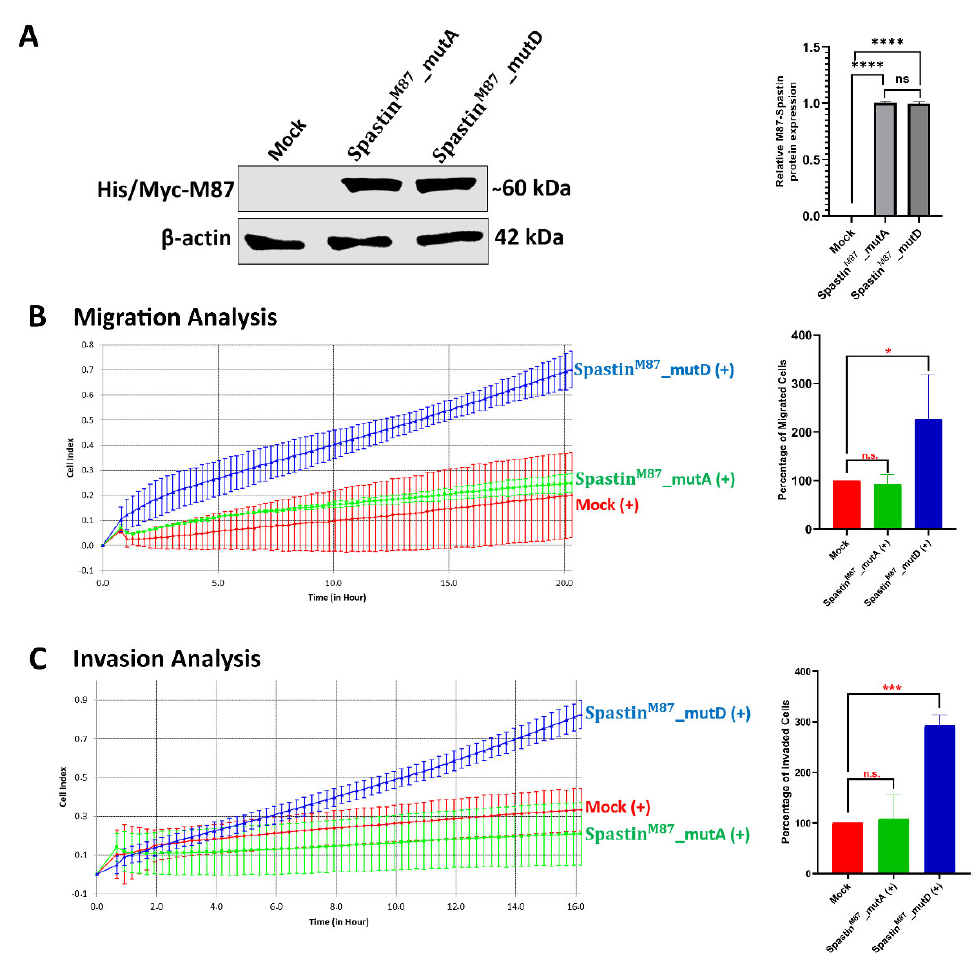
Figure 9. Real ‐ time monitoring and measurement of T98G cell motility upon M87 overexpression. ( A ) Expression levels of exogenous mutant M87-Spastin proteins were analyzed by Western blot (WB). T98G cells were transfected with either mock, Spastin M87 _mutA, or Spastin M87 _mutD vectors and analyzed 24 h post-transfection with immunoblotting using Myc-tag antibody for M87 proteins. β -actin was used as a loading control. Representative WB is shown, and relative densitometric values of M87-Spastin/ β -actin are reported in the right panel. ( B , C ) xCelligence impedance-based system was used for the migration ( B ) and invasion ( C ) analysis. Results were statistically analyzed by one-way ANOVA from two independent biological replicates containing at least three independent technical replicates. Data are represented as mean ± SD; n.s. p > 0.05, * p <0.05, *** p <0.001, and **** p < 0.0001 (right panel).